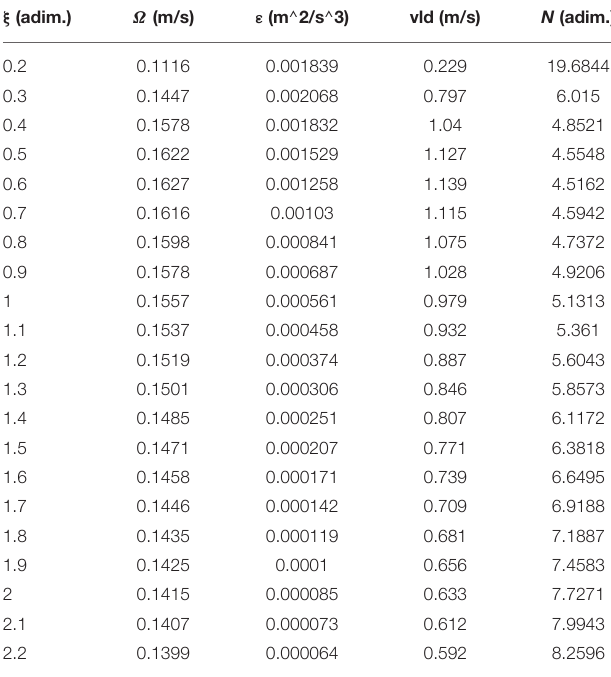
, and N with varying ξ . d